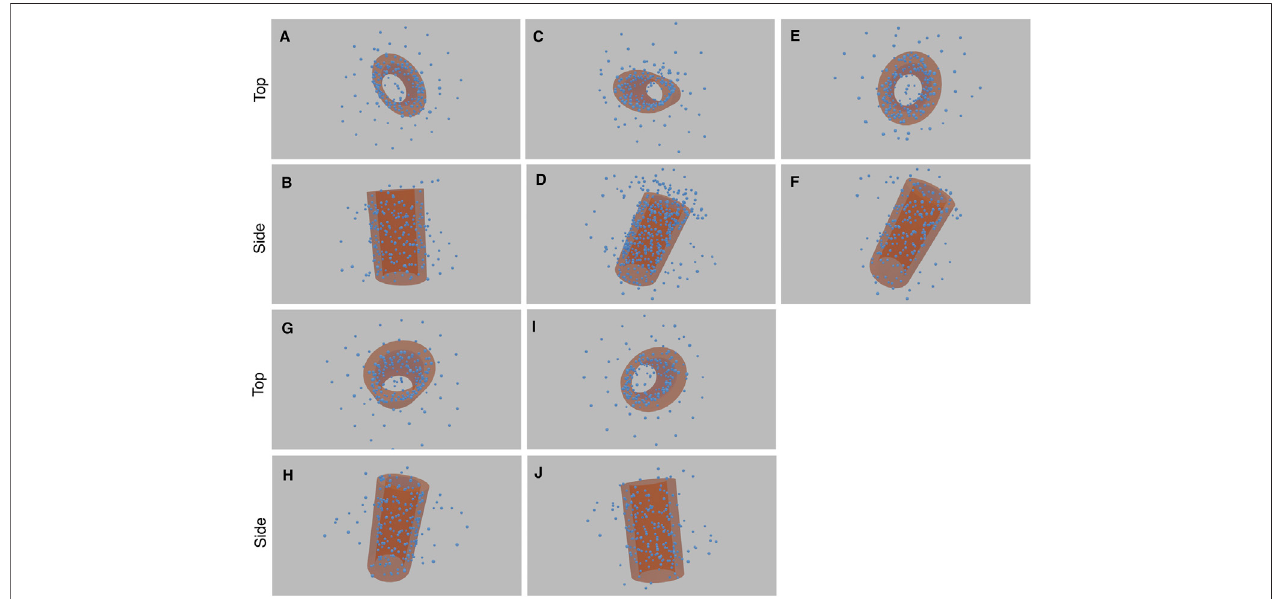
FIGURE12 | Results of the fi ve experiments on SIM/expansion Microscopy ofglutamylated tubulin inpuri fi ed centrioles (each with atop and sideviewimage pair). The fi rstexperimentcomprisesimage (A) and (B) ,thesecondexperiment (C) and (D) ,andsoforth.Thecylinderstructurewithinthebluepointcloudishighlightedwithan orange cylinder. See Supplementary Video S3, 4 for greater